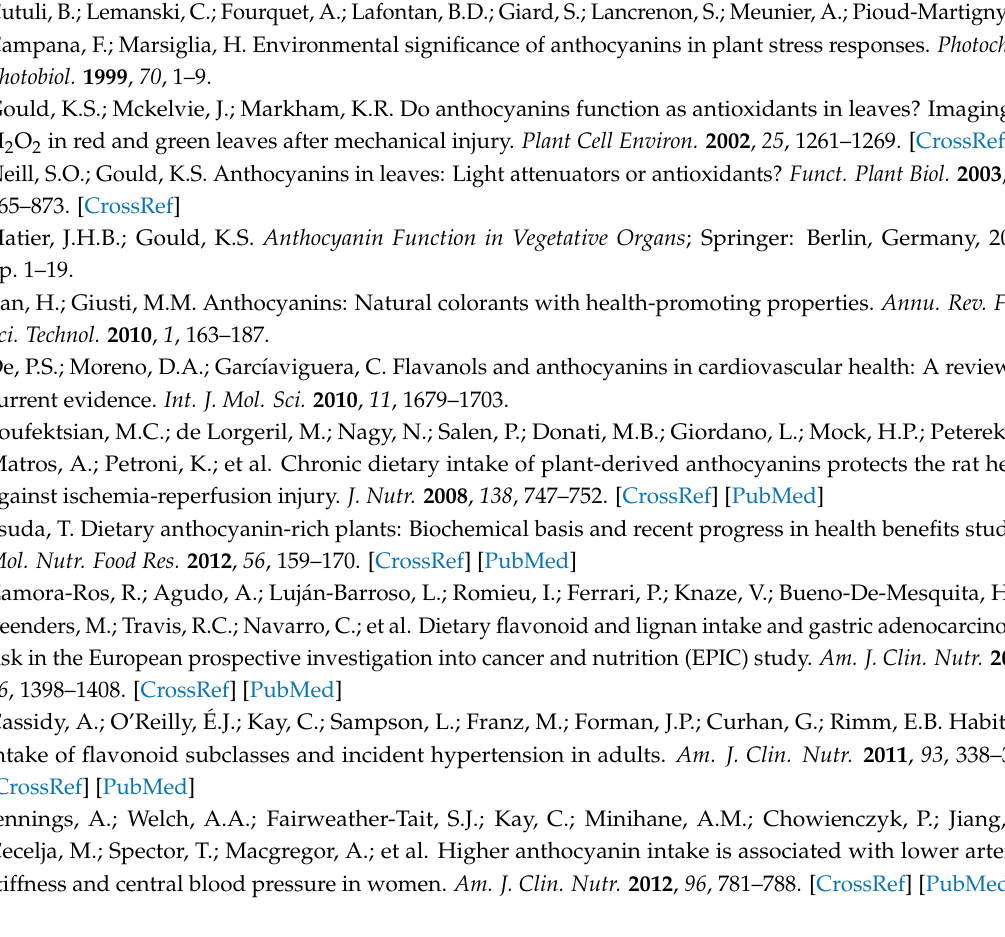
Table S1: Gene graph and primer sequences used for RT-qPCR; Table S2: Differentially expressed genes identified in the comparisons of LT vs. CK and HL vs. CK in B. semperflorens leaves; Table S3: Annotation of the DEGs identified in the comparisons of LT vs. CK and HL vs. CK in B. semperflorens leaves; Table S4: KEGG analysis results of the identified DEGs in the comparisons of LT vs. CK and HL vs. CK in B. semperflorens